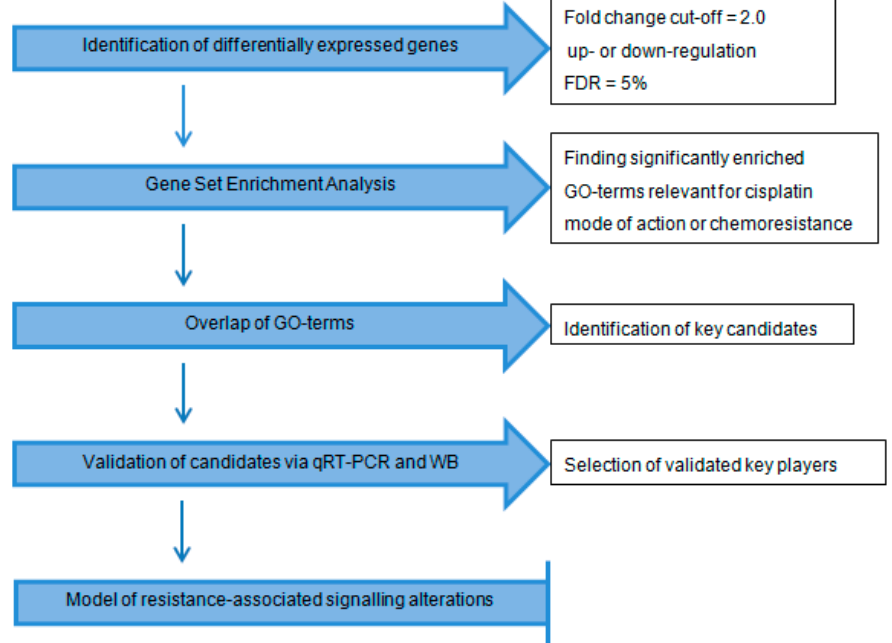
Figure 1. Flow chart of the array data processing (FDR: false discovery rate; GO: Gene Ontology; WB: Western blot).